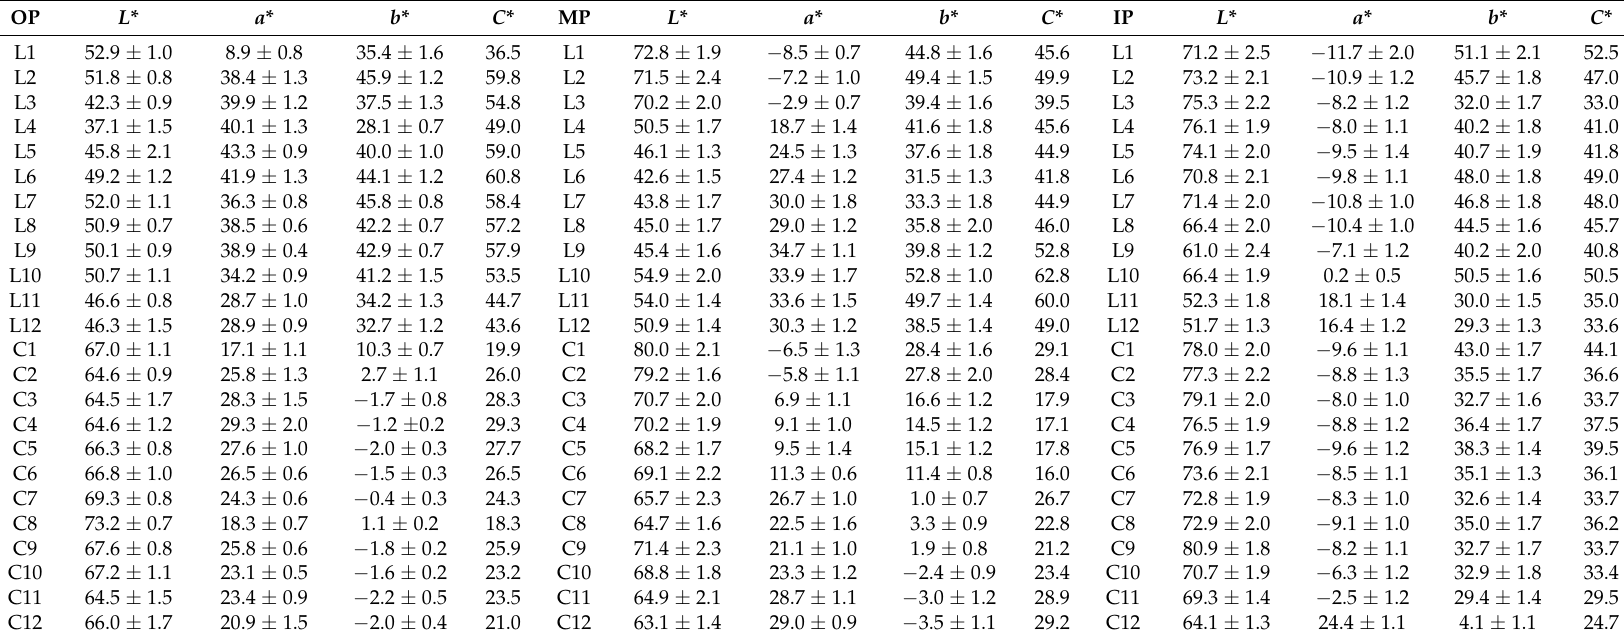
Table 1. Color measurements of two varieties of Ranunculus asiaticus